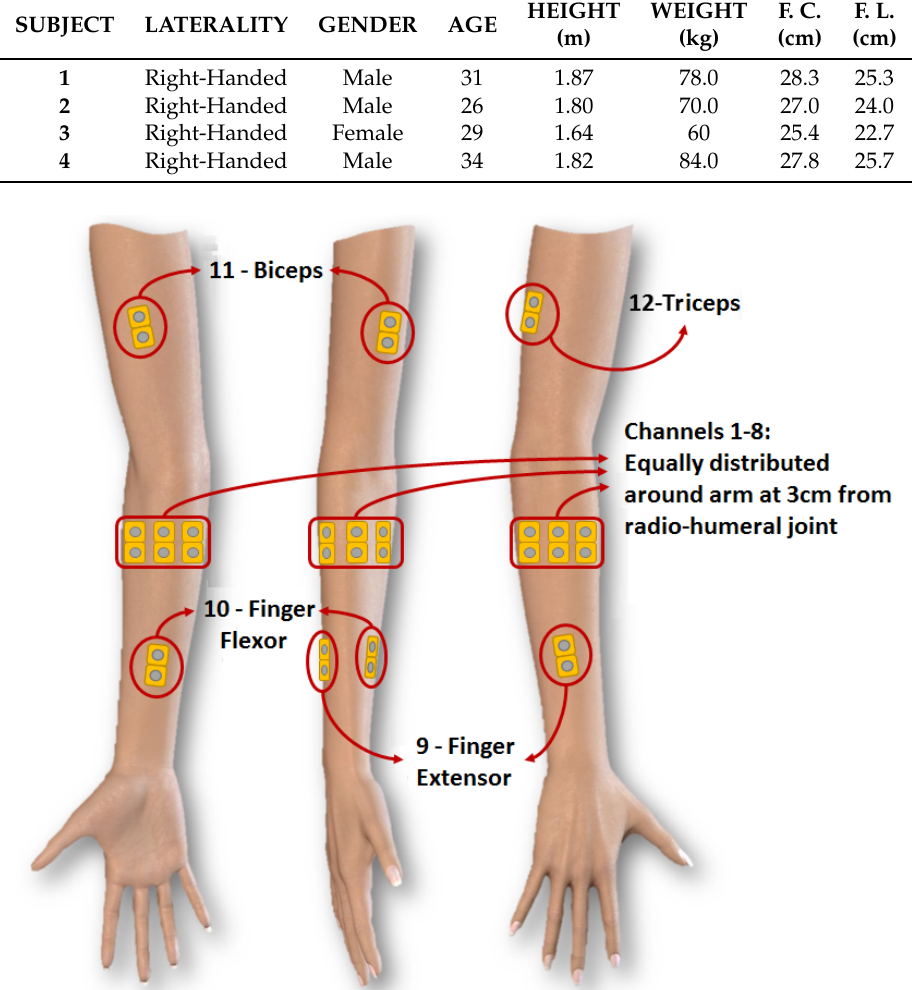
Table 1. IEE database subject description (F.C: Forearm Circumference, F.L: Forearm Length (F.L)).